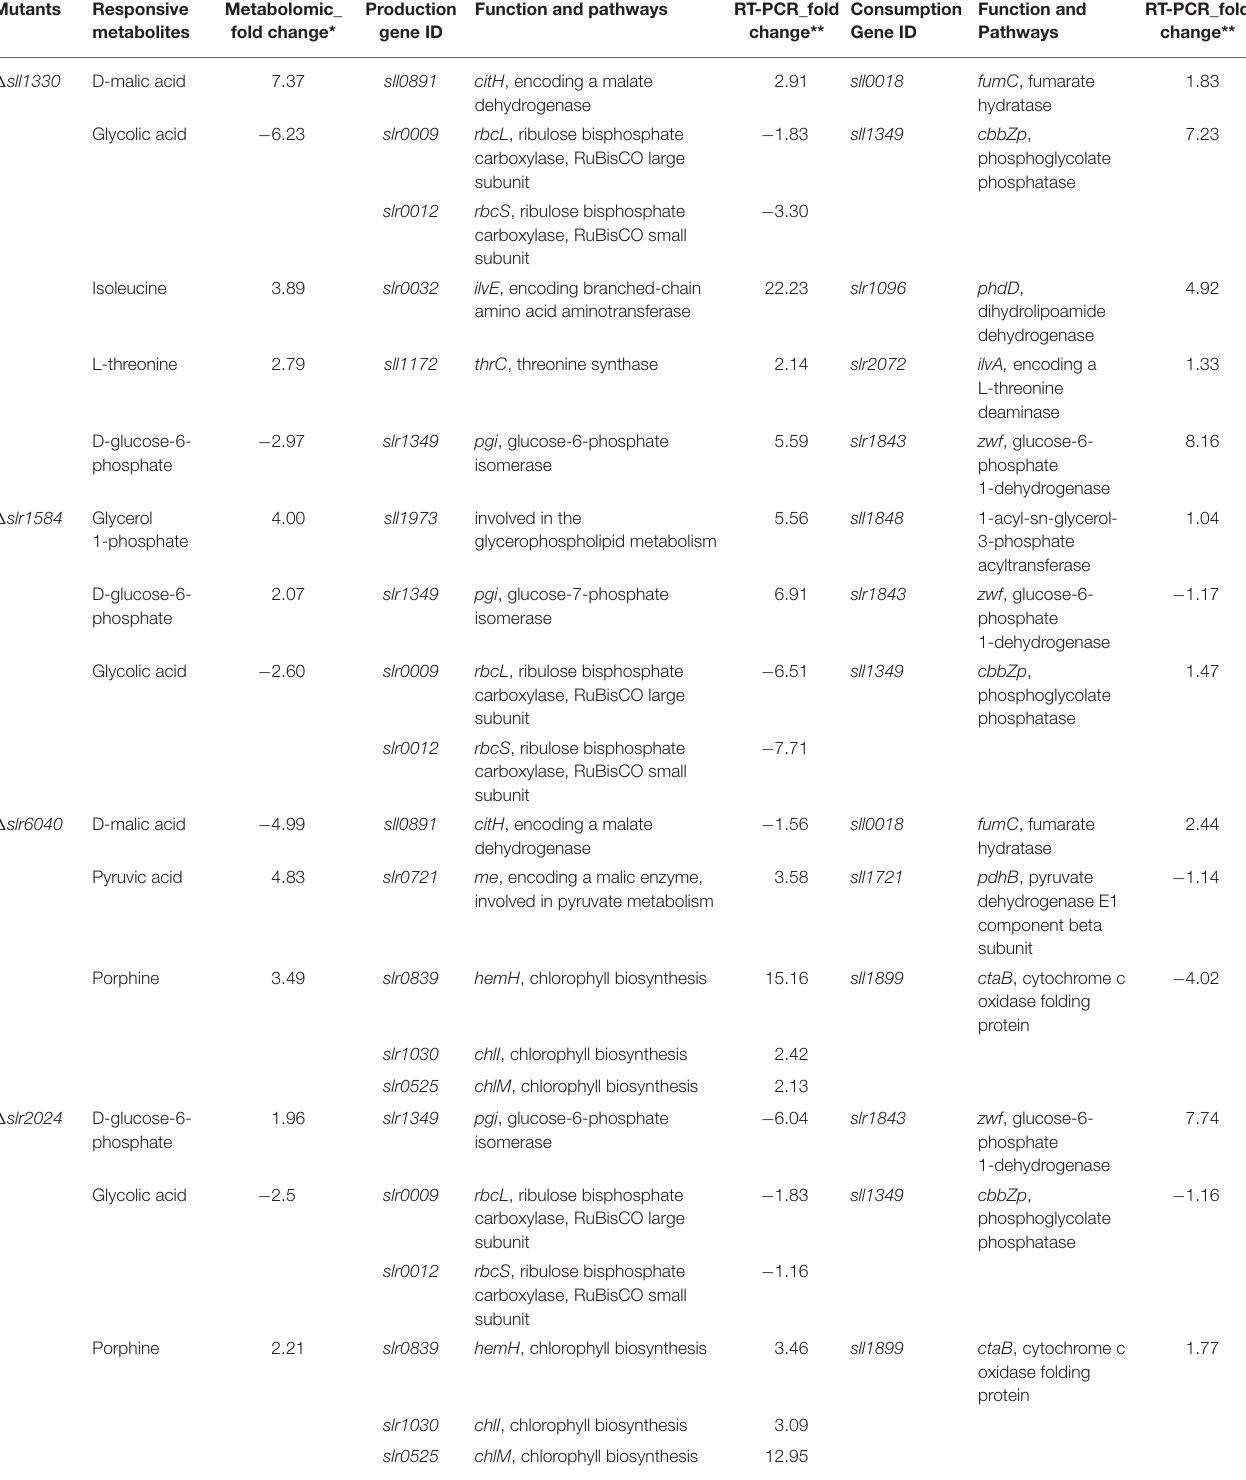
TABLE 1 | RT-qPCR confirmation of the metabolic changes in seven most regulated RR mutants. Mutants Responsive